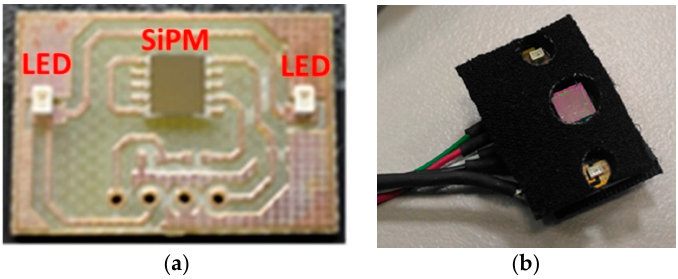
Figure 2. PPG probe comprising a SiPM detector and LED emitters. Detailed PCB ( a ) and the package ( b ) LT M673 LEDs (OSRAM, Milan, Italy) based on InGaN technology (in SMD package) emitting at